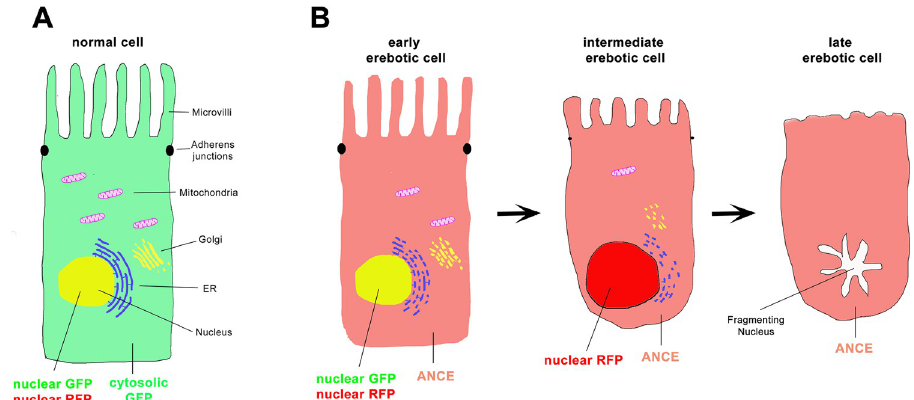
Fig 1. The morphology of erebosis. (A) Depicted is a normal EC expressing cytosolic GFP (illustrated in green) as well as nuclear GFP and RFP (illustrated in yellow). It also contains a nucleus, organelles (mitochondria, ER, and Golgi), cellular junctions, and microvilli. (B) Erebotic ECs are characterized by loss of proteins, organelles, and nuclear content as well as shorter microvilli. During early erebosis, cytosolic GFP is degraded, while nuclear GFP and RFP persists. Instead, erebotic ECs accumulate ANCE (illustrated in red in the erebotic cell)) through extracellular uptake. ANCE and GFP display a complementary staining pattern. At intermediate erebosis, nuclear GFP is degraded, but nuclear RFP (red) still persists. Erebotic nuclei are larger than normal, and loose nucleoli. At late erebosis, nuclear RFP is also degraded. Fragmented nuclei can be detected via TUNEL labeling. Microvilli are significantly shortened. A AU : AnabbreviationlisthasbeencompiledforthoseusedthroughoutFig 1 : Pleaseverifythatallentriesarecorrect : NCE, angiotensin-converting enzyme; EC, enterocyte; ER, endoplasmic